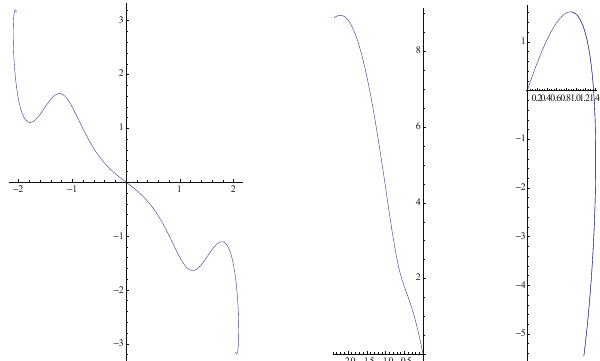
Fig. 4. A dual circular slant helix is a triple product curve of above three curves in D